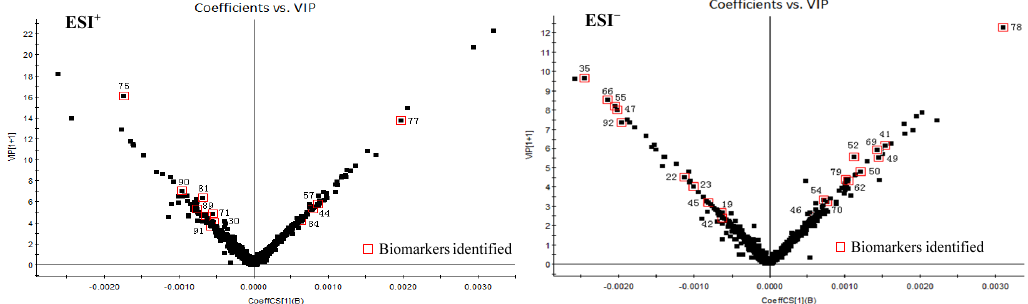
Figure 4. The OPLS ‐ DA of HC and HD in positive mode (ESI + ) and negative mode (ESI − ).